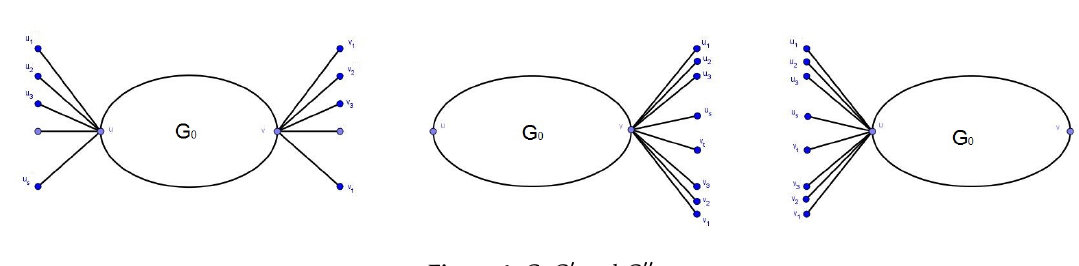
Figure 4. G , G (cid:48) and G (cid:48)(cid:48) .